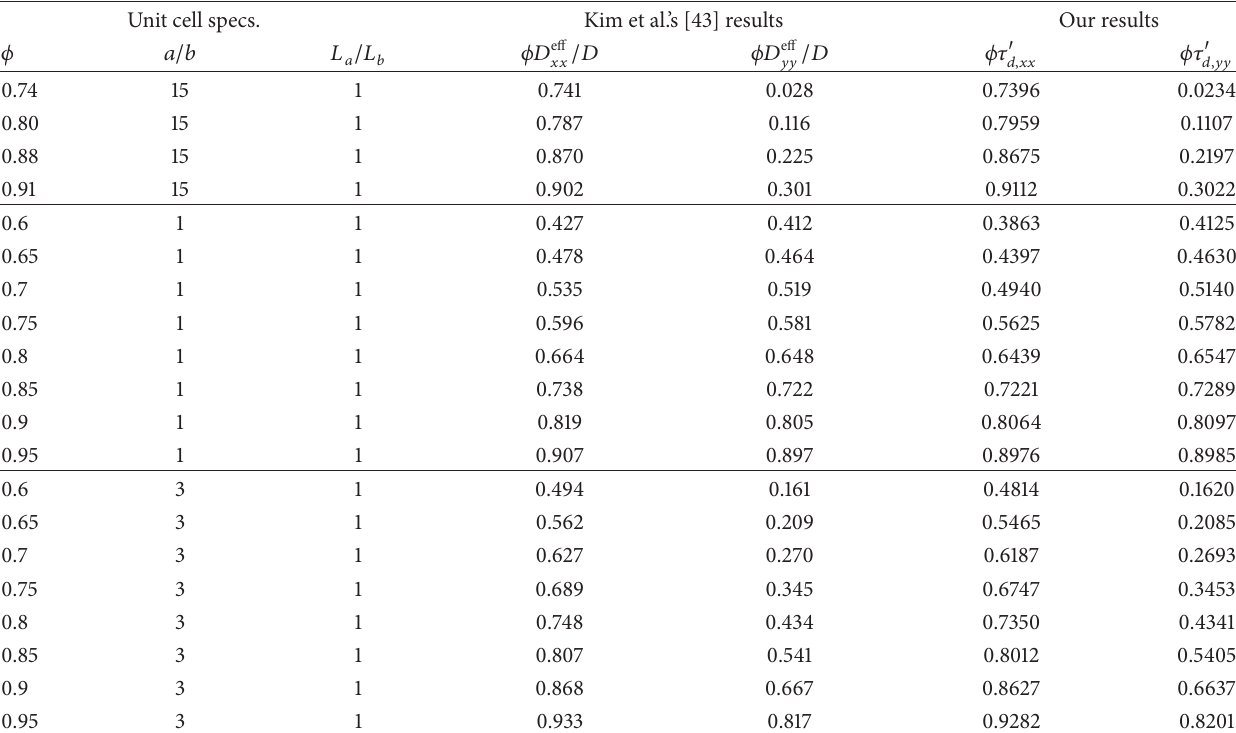
Table 6: Data comparison for diffusive